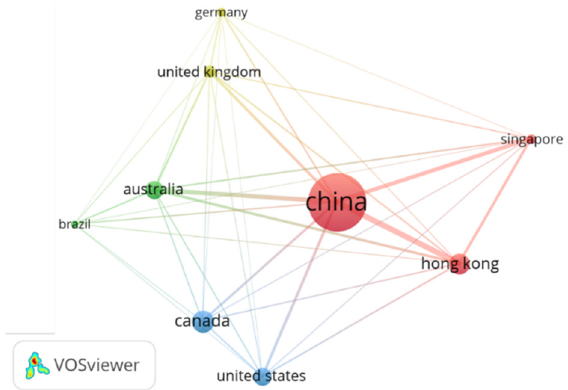
Figure 7. Mapping results of the countries of origin of the published documents.